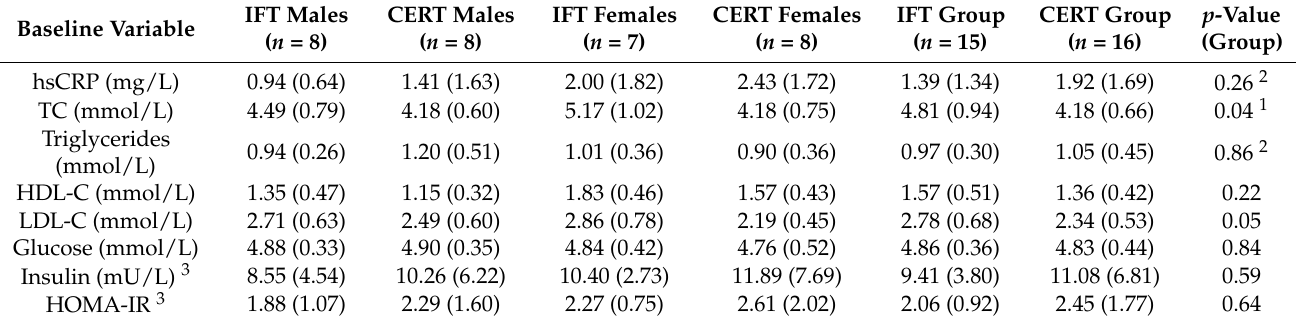
Table 3. Baseline values of cardiometabolic blood markers according to intervention group and sex.